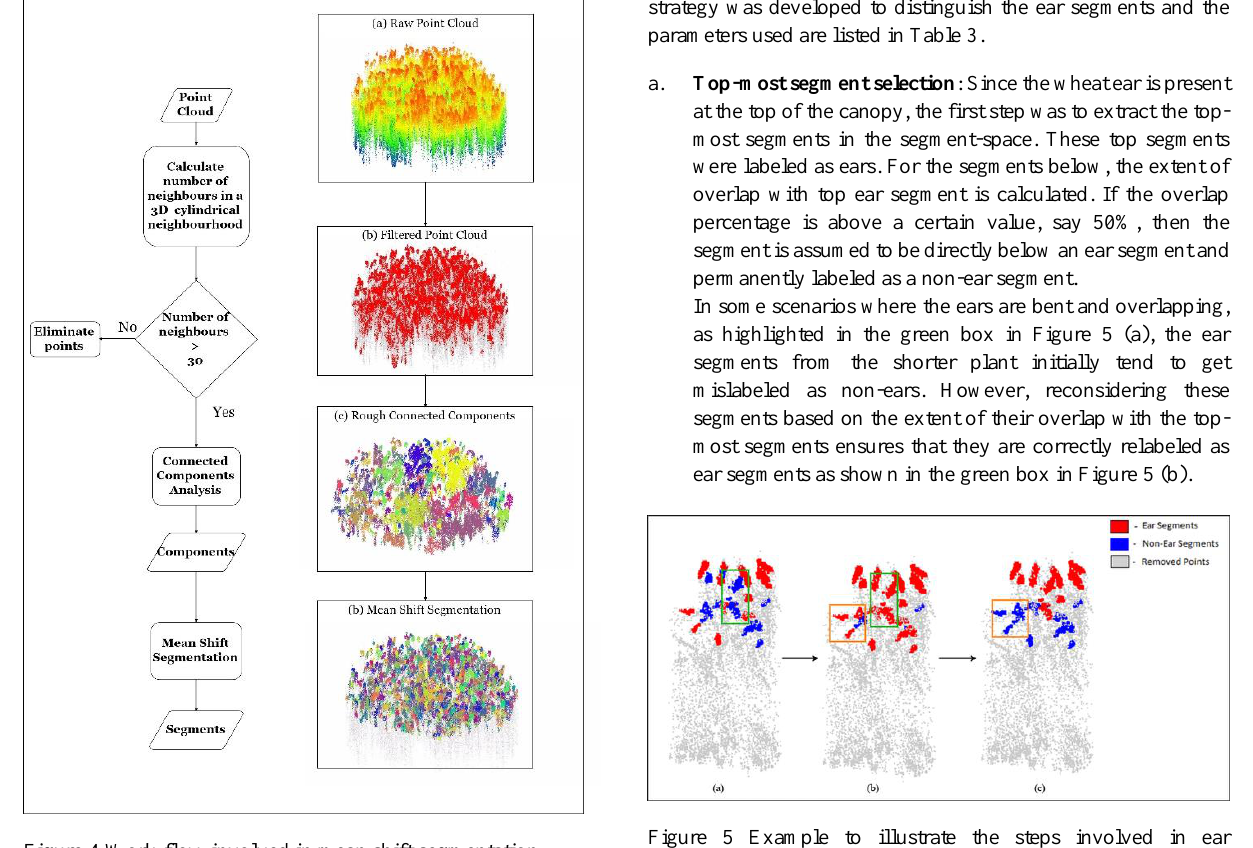
Figure 4 Work-flow involved in mean shift segmentation illustrated with a sample point cloud.